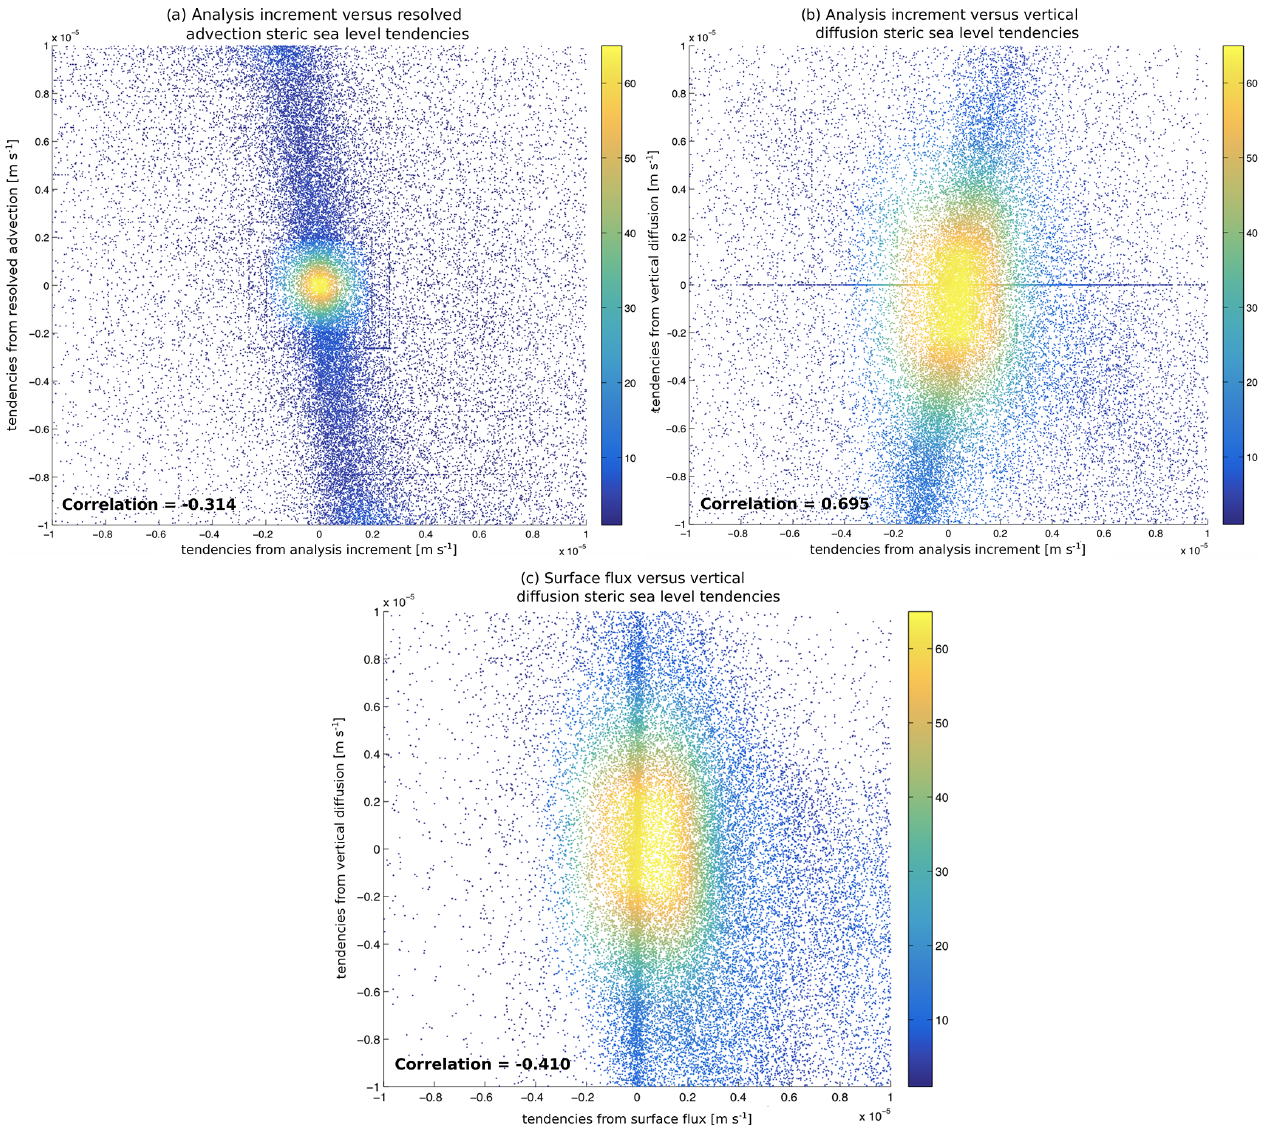
Figure A3. Scatterplots between several of the most locally dominant tendency terms in the steric sea level budget of the GMAO S2S Ocean Analysis, averaged over the entire runtime period (2012–2017): shown are (panel a ) the analysis increment (abscissa) versus the resolved advection (ordinate) terms, (panel b ) the analysis increment (abscissa) versus the vertical diffusion (ordinate) terms, and (panel c ) the surface flux (abscissa) versus the vertical diffusion (ordinate) terms. The more yellow colors indicate a greater density of dots in the scatterplots. The more blue colors indicate a lower density of dots in the scatterplots. Also listed in each panel are the correlations between each of the